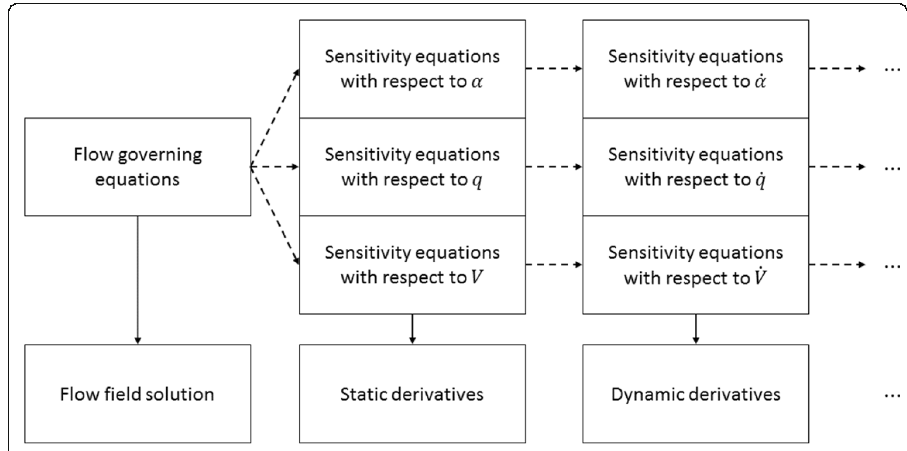
Fig. 1 The illustration of the solution sequence for the computation of the stability